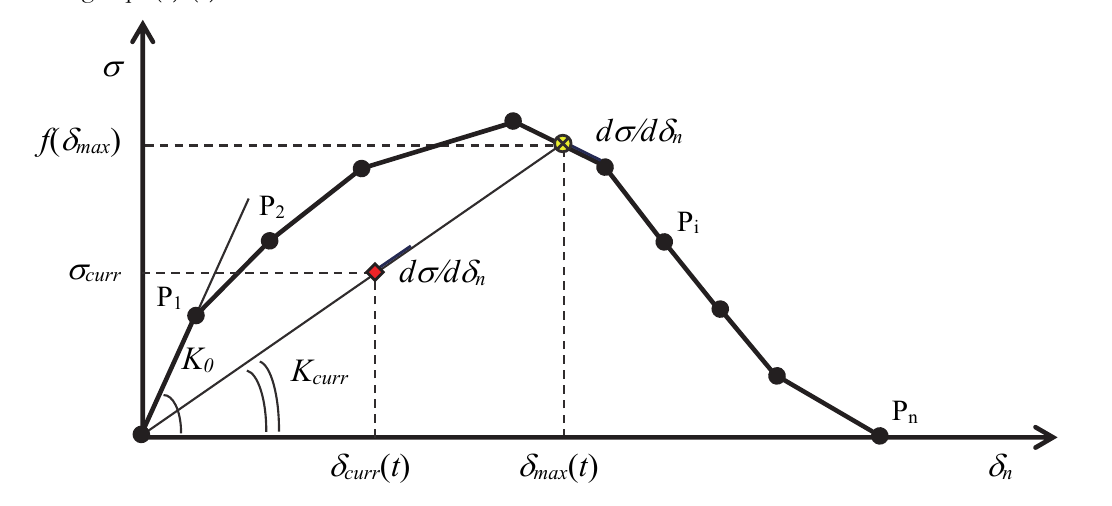
Figure 5: Interpolated cohesive law – closing of the